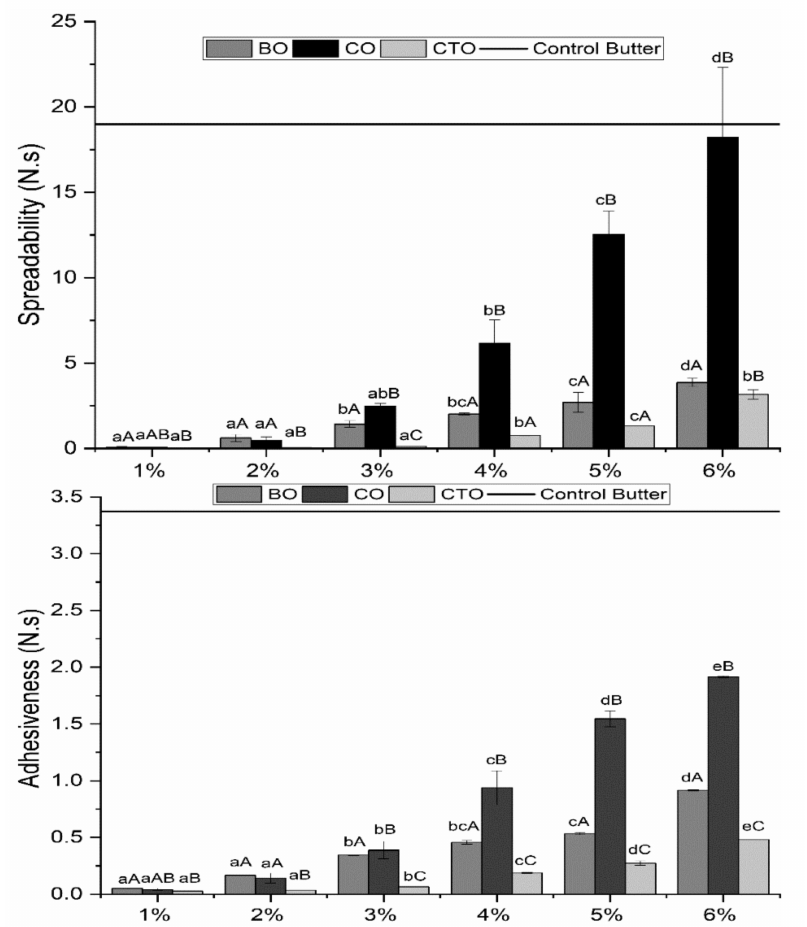
Figure 4. Texture analysis results for firmness ( top ), spreadability ( middle ) and adhesiveness ( bottom ). Different small letters indicate statistically significant differences between different concen- trations within the same organogelator, while different capital letters indicate statistically significant differences between different organogels ( p < 0.05). Extra virgin olive oil obtained values of 0.1035